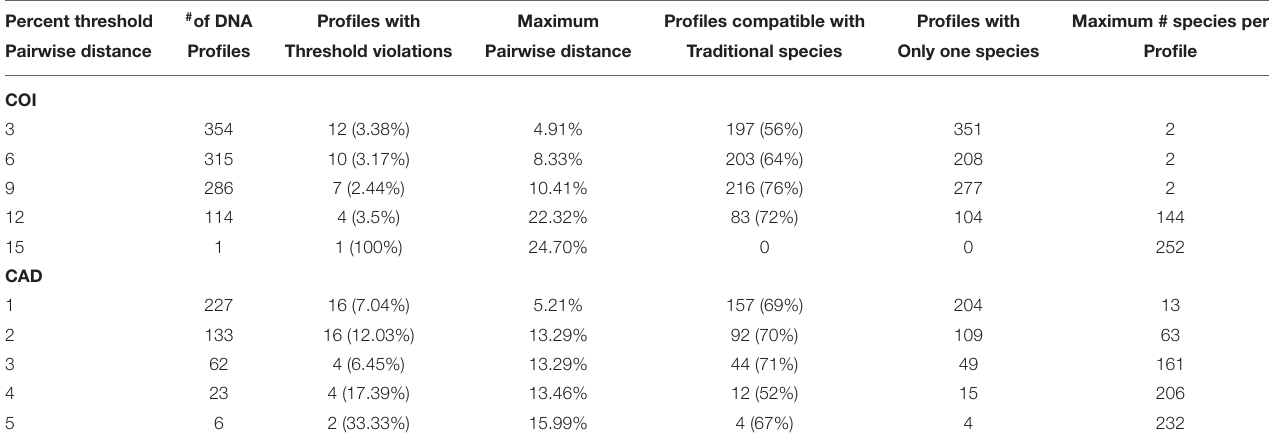
TABLE 3 | DNA clusters based on a pair-wise distance thresholds for interspecific sequence comparisons. Percent threshold # of DNA Profiles with Maximum Profiles compatible with Profiles with Maximum # species